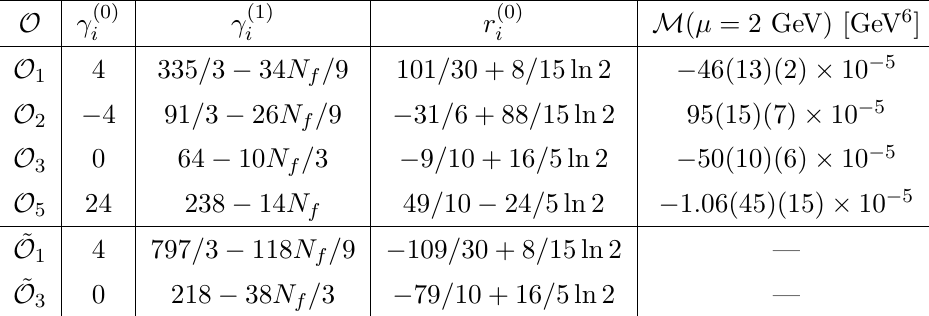
Table 1 . The one- and two-loop running factors γ (0) , for each operator O r (0) i